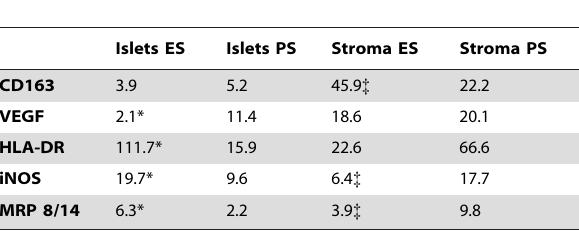
Table 2. Summary of the cellular distribution results in the tumour islets and stroma indicating the median density of cells/mm 2 in extended survival (ES) and poor survival (PS)